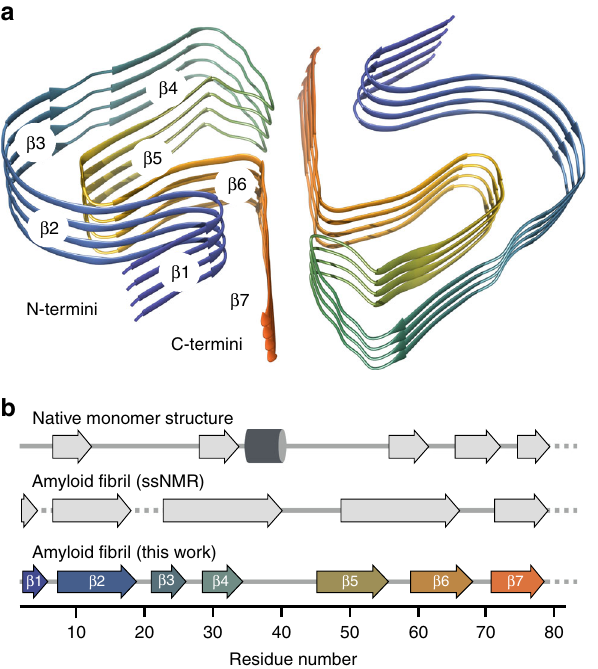
(Figs. 1a and 3a). The bent β -arch motif between strands β 4